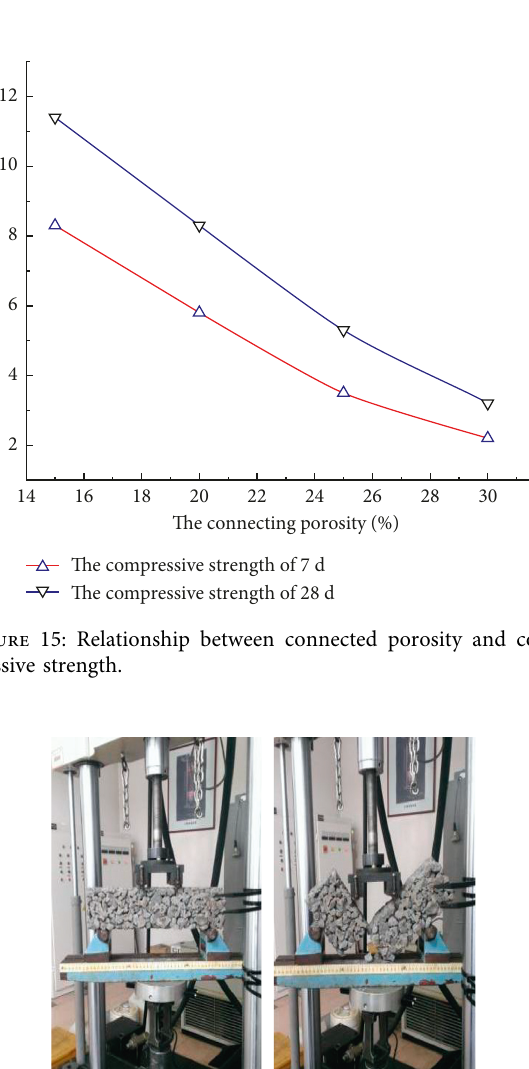
Figure 16: Flexural tensile strength tests.